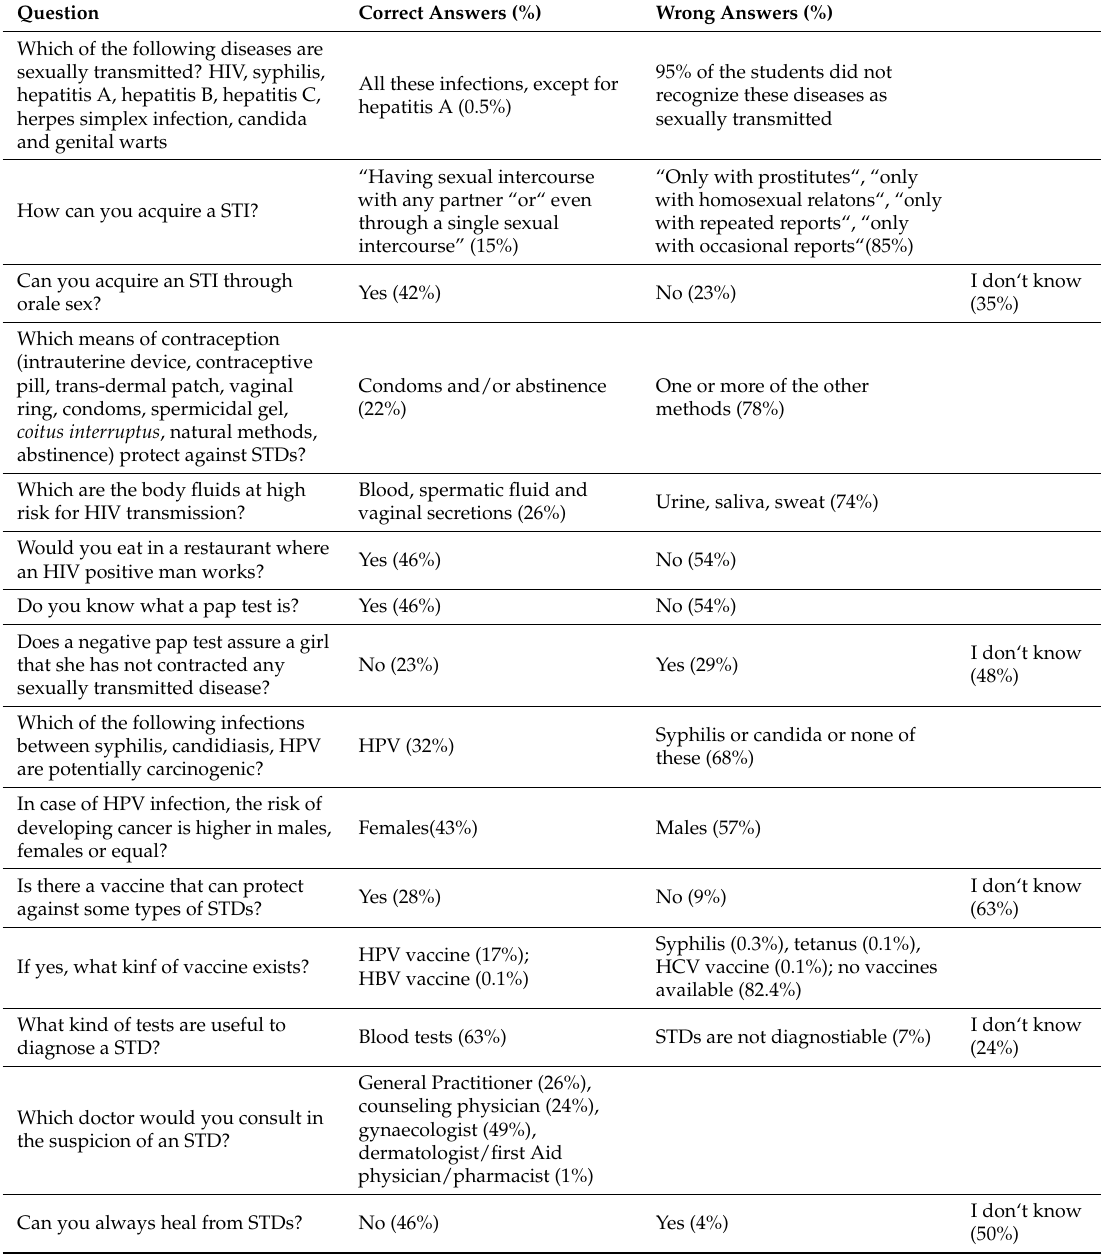
Table 2. Results of the second section of the